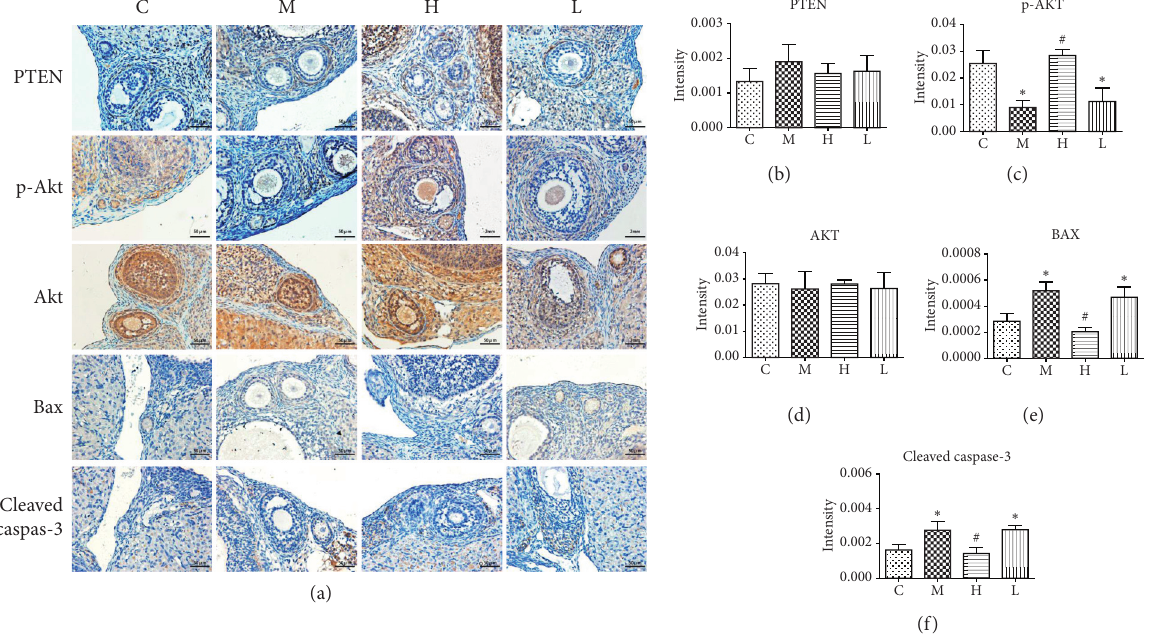
Figure 7: Immunohistochemistry analysis of AKT signaling pathway molecules in different groups. ∗ : significant compared to group (C) ( P < 0 . 05 ) ; #: significant compared to group (M) ( P < 0 . 05 )